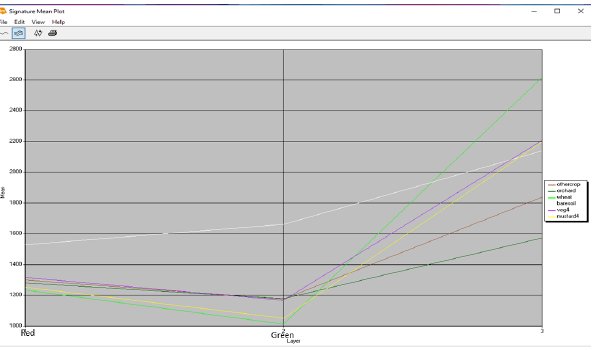
Figure 7. Crop signatures for wheat (green light), mustard (yellow), vegetables (purple), orchard (green dark), other crops(brown) and baresoil (white) in Sentinel -2 data